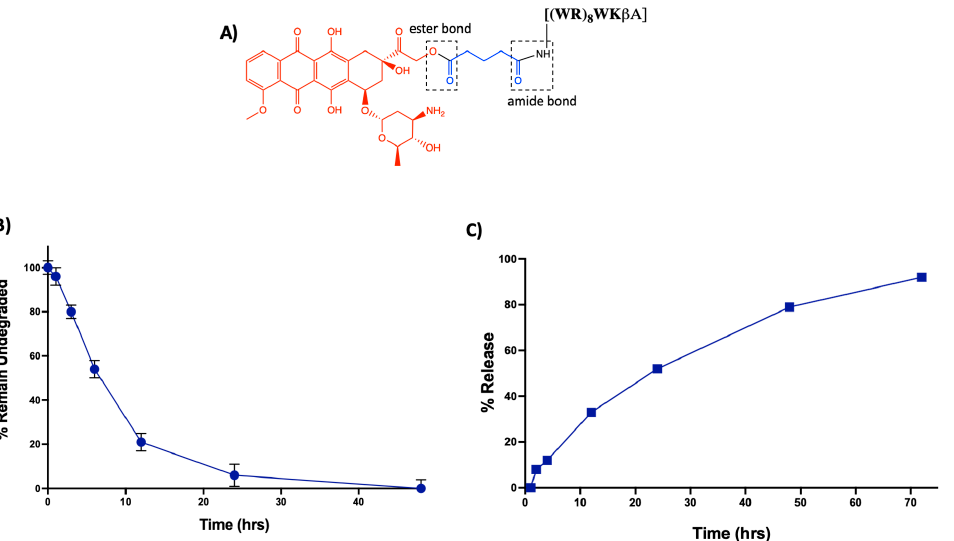
Figure 7. ( A ) Schematic representation of the possible susceptible bonds in [(WR) 8 WK β A]-Dox con- jugate. ( B ) Stability analysis of [(WR) 8 WK β A]-Dox conjugate in human plasma. ( C ) Intracellular re- β A]-Dox conjugate in human plasma. ( C ) Intracellular lease of free Dox from [(WR) 8 WK β A]-Dox conjugate. conjugate. ( B ) Stability analysis of [(WR) 8 WK release of free Dox from [(WR) 8 WK β A]-Dox